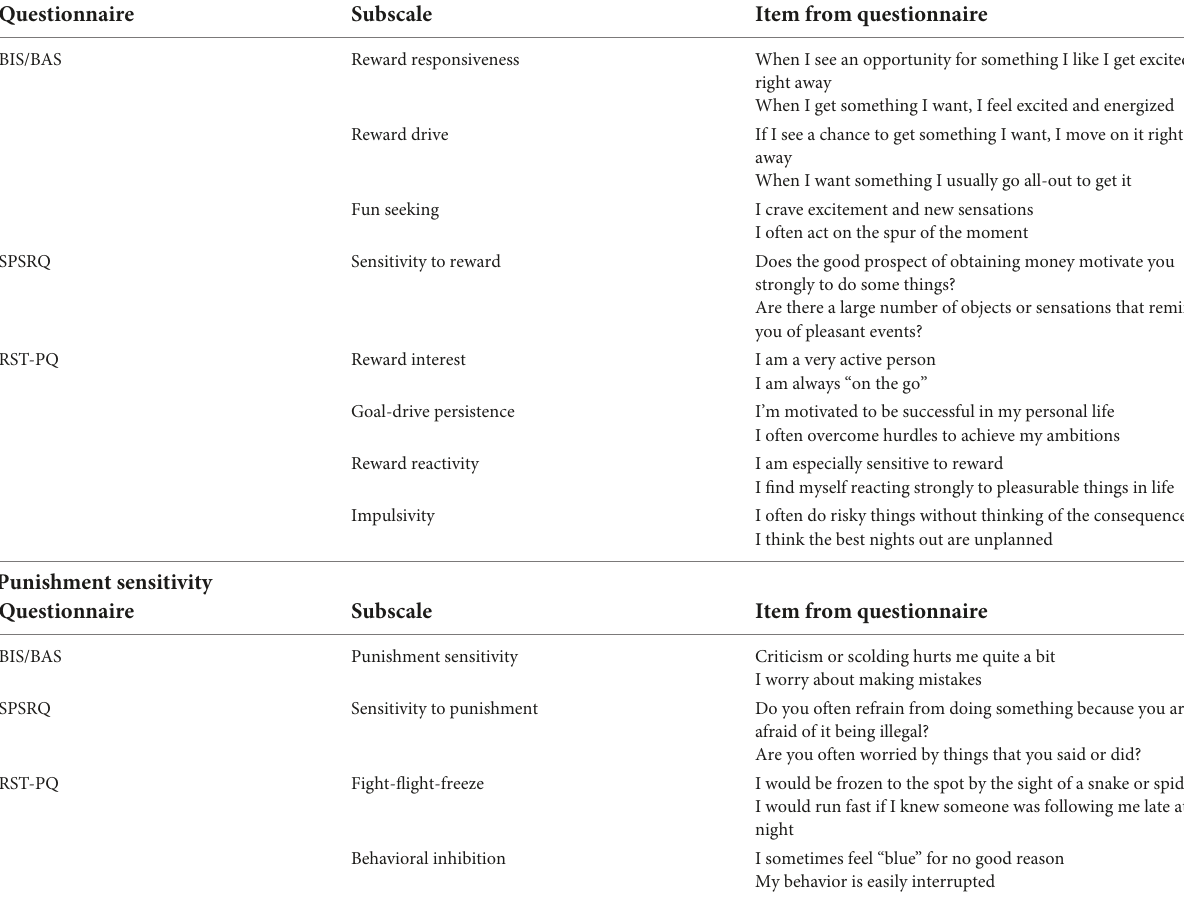
TABLE 1 Subscales and items of the BIS/BAS, SPSRQ, and RST-PQ. Reward